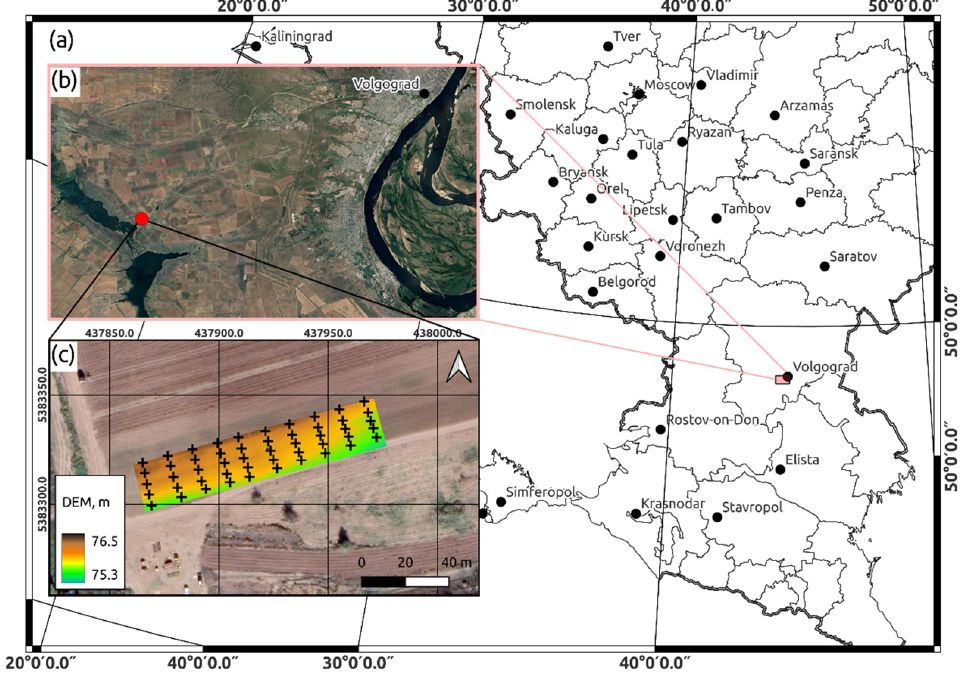
Figure 1. Location of the test plot: ( a ) administrative boundaries of the regions of Russia; ( b ) Google Earth imagery of the study area (red marker shows the position of Vodny settlement); ( c ) test plot with transects of soil sampling locations (+) with digital elevation model and Google Earth imagery as underlayers.